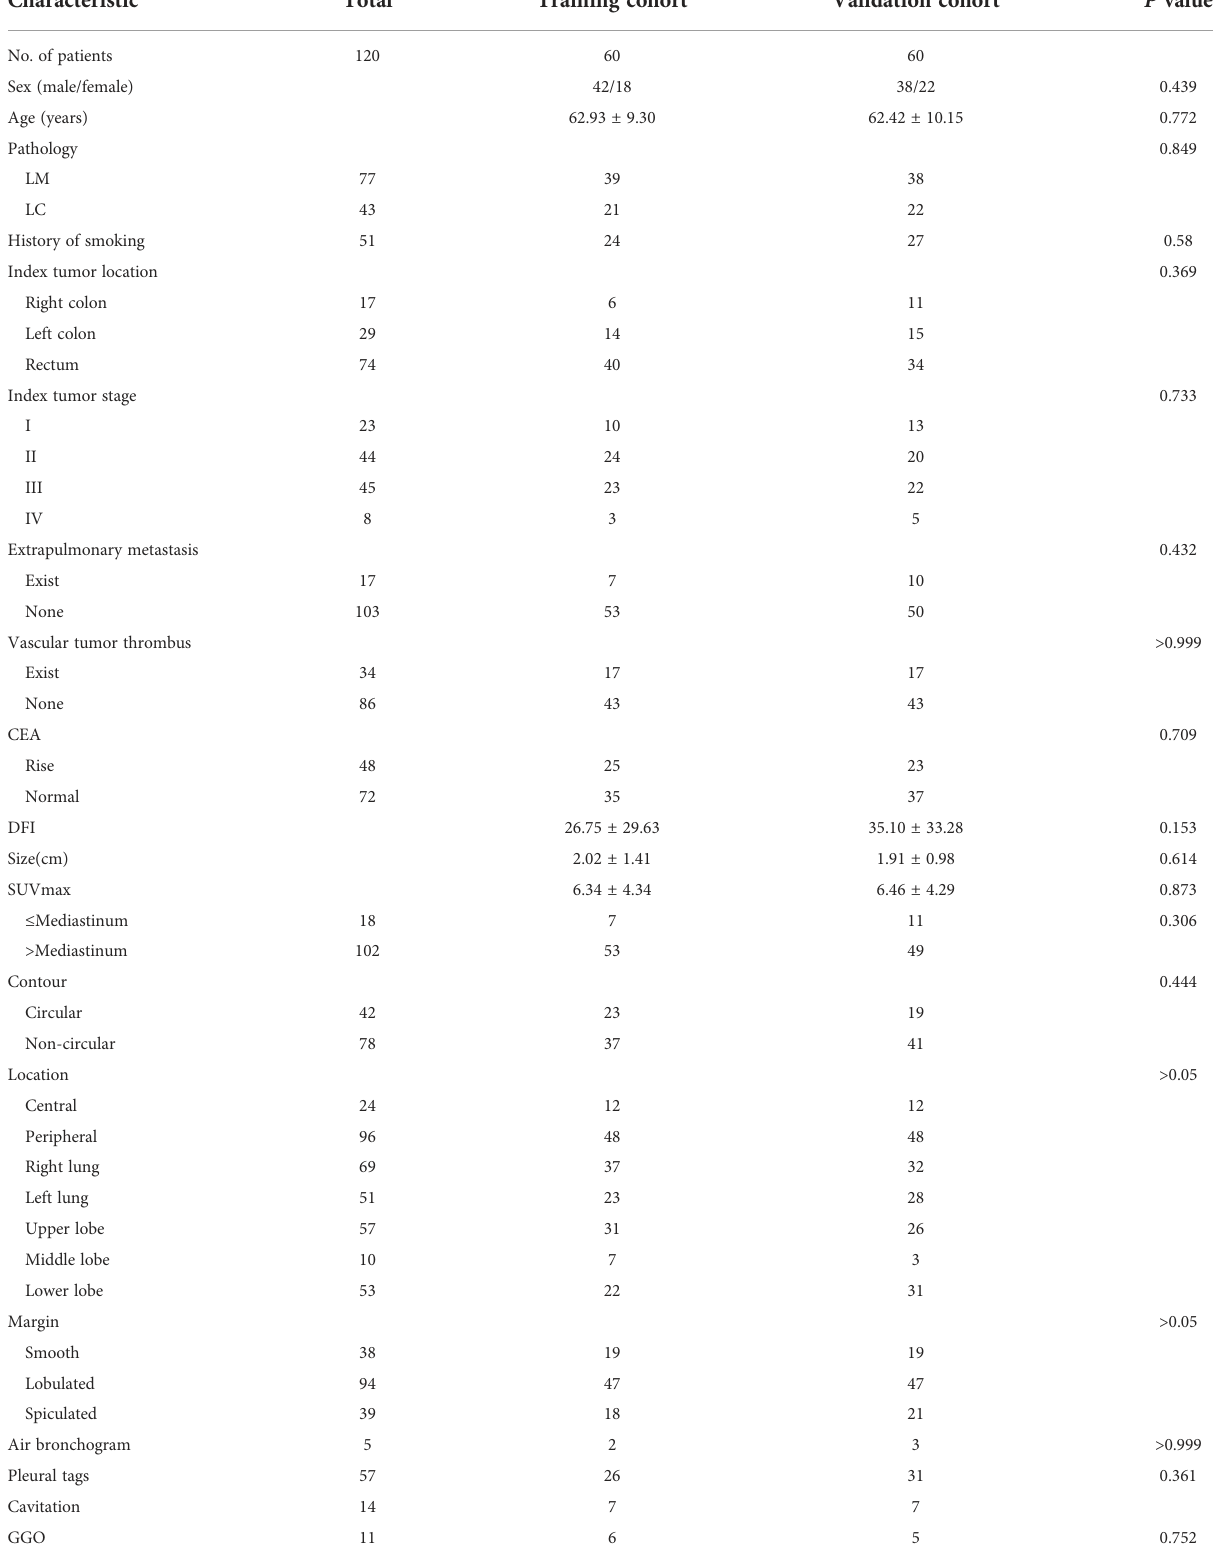
TABLE 1 Clinical characteristics of patients and